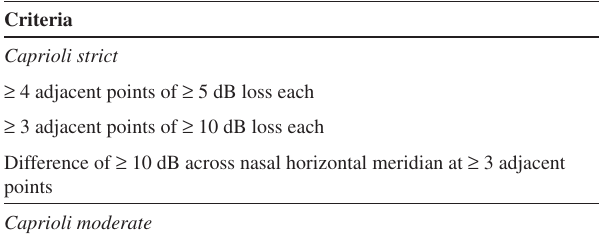
Table 1 - Criteria for visual field abnormality